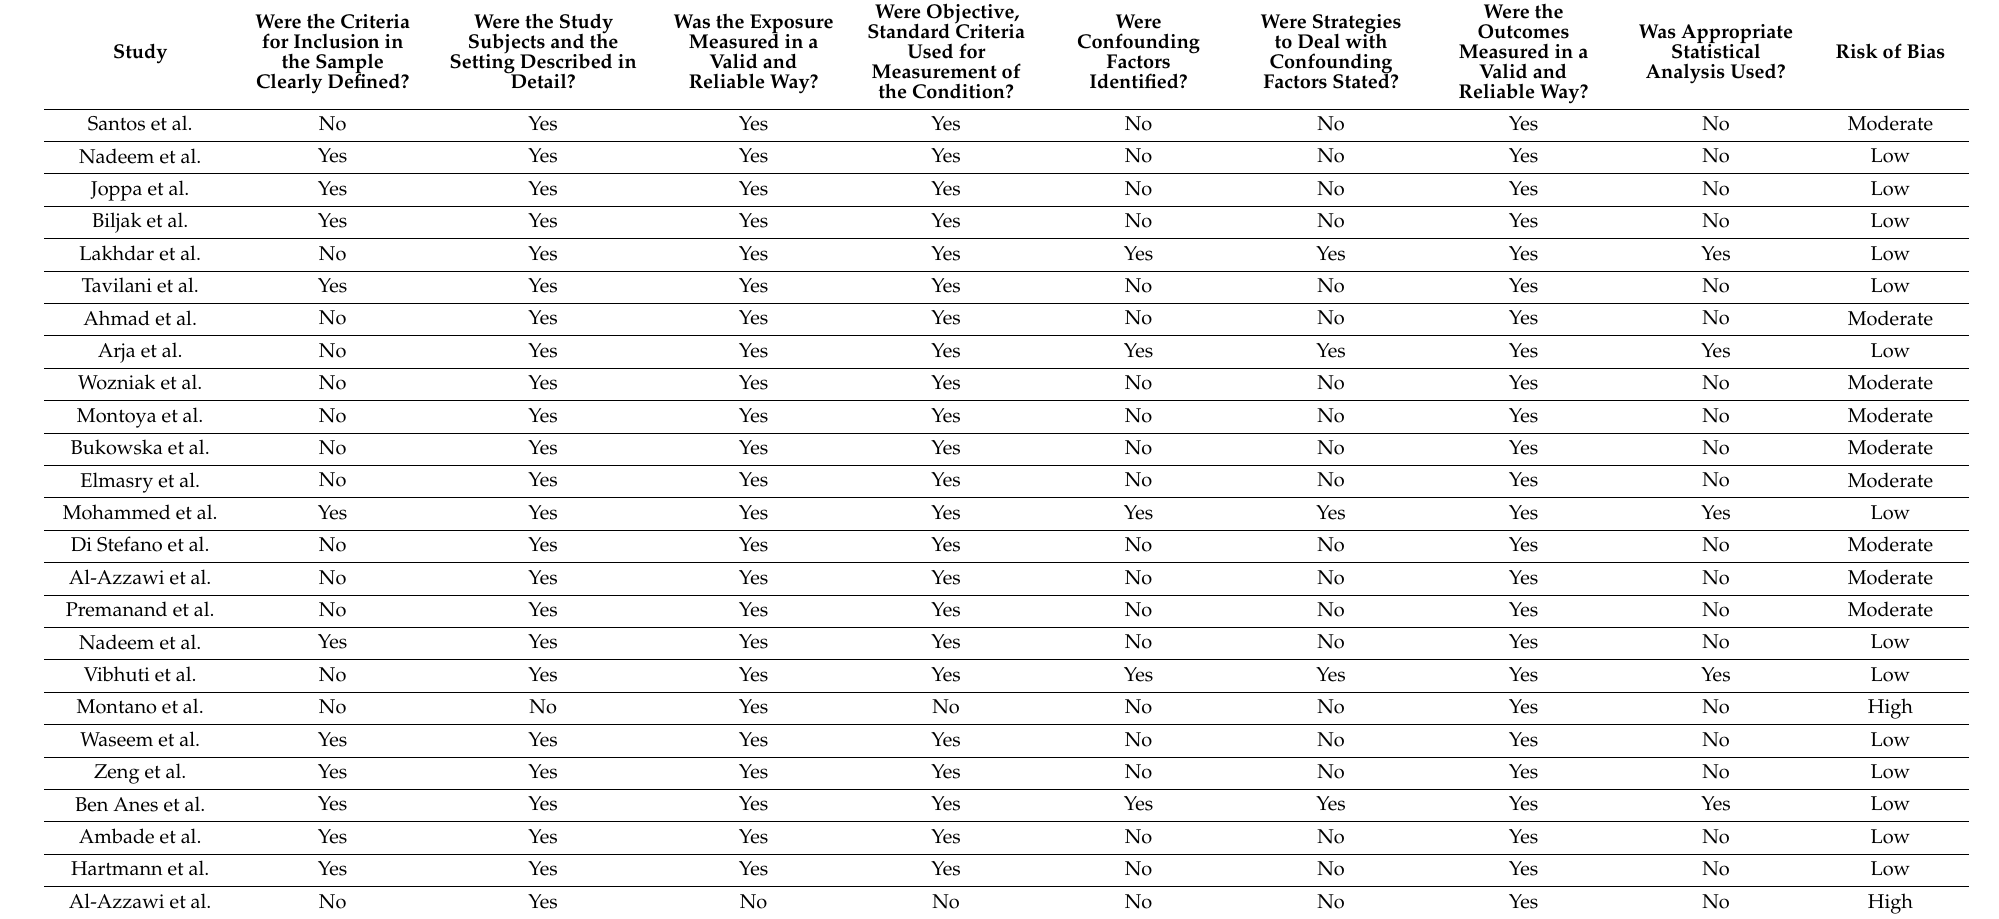
Table 2. The Joanna Briggs Institute critical appraisal checklist for analytical cross-sectional